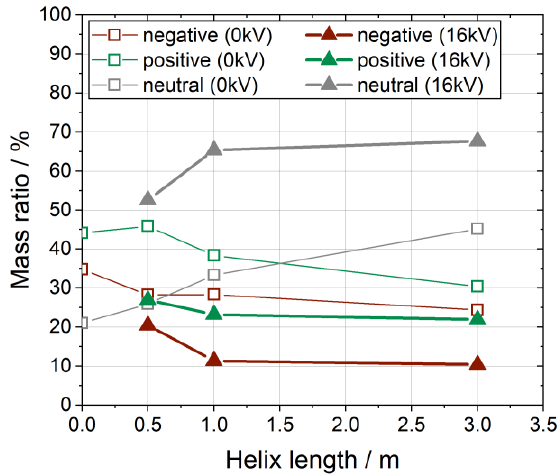
Figure 8. Charged and neutral mass fractions of the particles with no external potential (0 kV) and potential at the PZNC (16 kV) of Saxolith. potential at the PZNC (16 kV) of